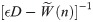
Spatial filtering of external input and the dependence of suppression on outgoing synaptic projection width.a) The magnitude of the spatial filter, [ϵD-W˜(n)]-1, imposed by recurrent connections (purple), the external input (X˜(n), green) and the resulting firing rate profile (r˜(n), black) as a function of the spatial frequency, ∥n∥=m2+n2, from the simulation in Fig 5j–5o. Magnitude is measured by the Frobenius norm for [ϵD-W˜(n)]-1. Curves normalized by their peaks. b) Firing rates of excitatory (red) and inhibitory (blue) neurons with receptive fields at the center of a grating stimulus plotted as the width of the stimulus increases (represented by increasing σX) using parameters from Fig 5j–5o. c) Same as b, but the excitatory rate is plotted for different widths of the excitatory synaptic projection width, αE. d) Same as c, but firing rates in L4 are shaped like a disc with radius σX instead of a Guassian with width parameter σX.